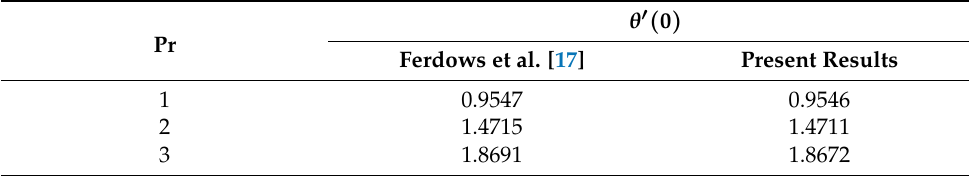
Table 1. Comparison values of Nusselt number θ (cid:48) ( 0 ) for various values of Prandtl number